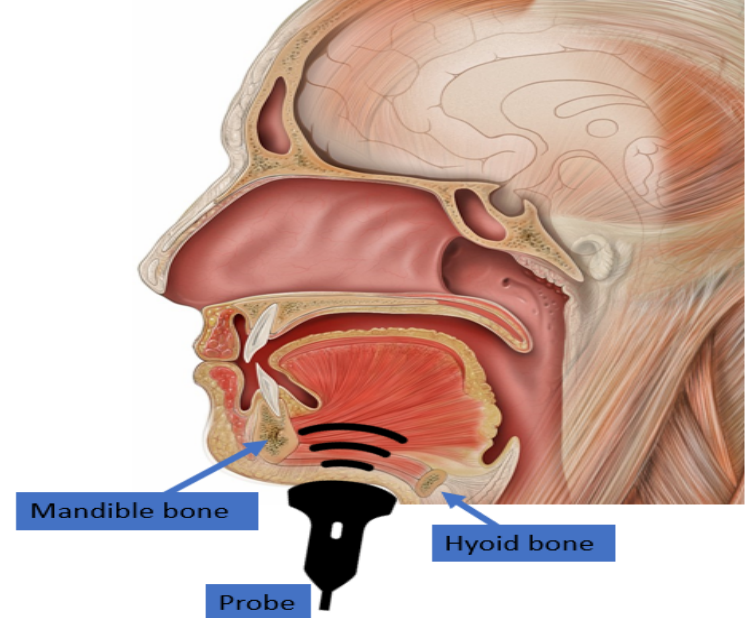
Figure 1. Overview of ultrasound probe placement beneath the chin. The ultrasound wave is shown in a black arc generated from the acoustic probe and propagated in the direction of the tongue. The effect of the hyoid and mandible bones is blocking part of the ultrasound wave, as shown in a black colour. The head and oral cavity picture was modified from the original picture for the case, courtesy of Associate Professor Frank Gaillard, Radiopaedia.org, rID: 35836, [86].